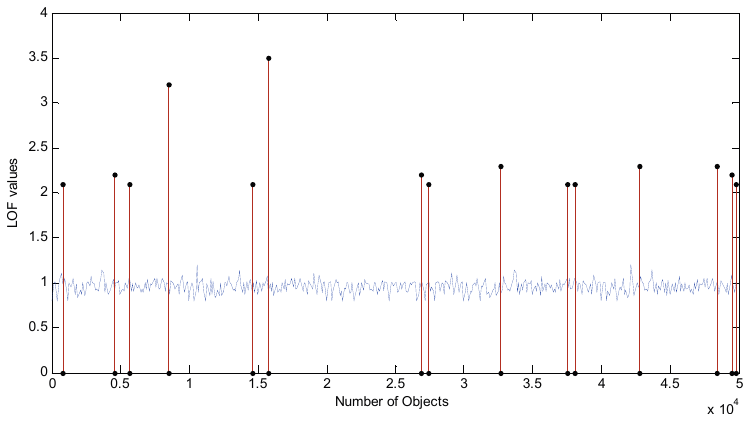
Figure 2. LOF values of objects with 15 outliers ( k =